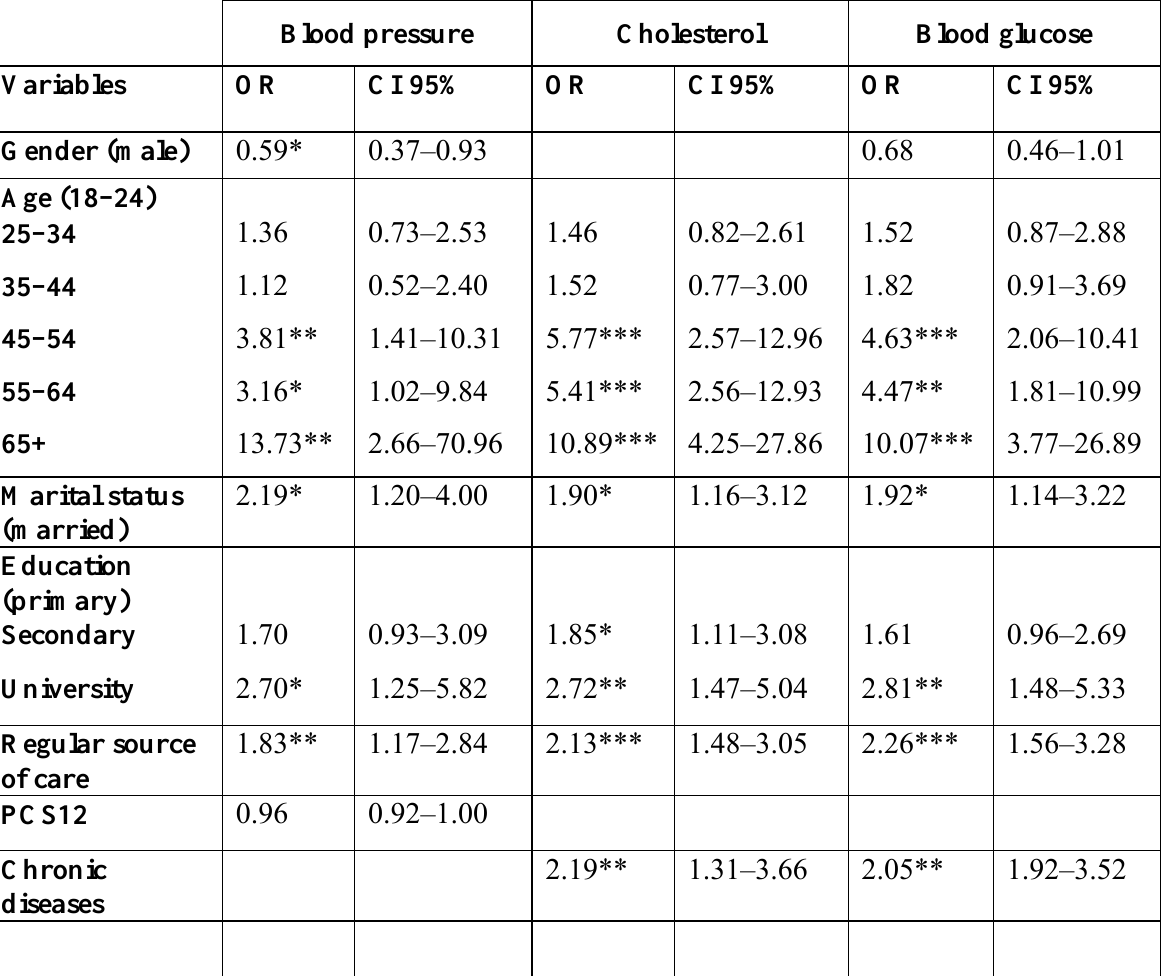
Table 4. Logistic regression models for blood pressure, cholesterol and blood glucose tests. Blood